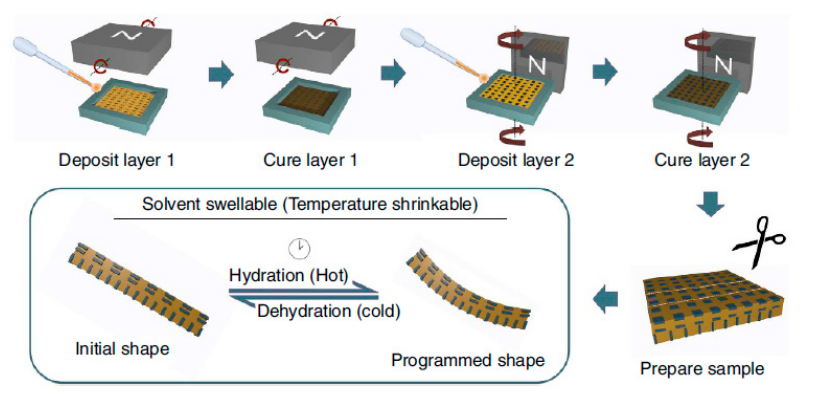
Figure 7. The production process of the magnetic soft material [43] .